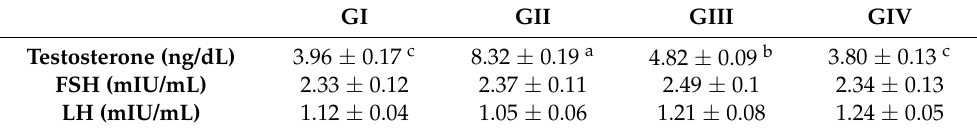
Table 3. Effect of acrylamide and/or earthworm extract on serum gonadal and pituitary hormones. GI GII GIII